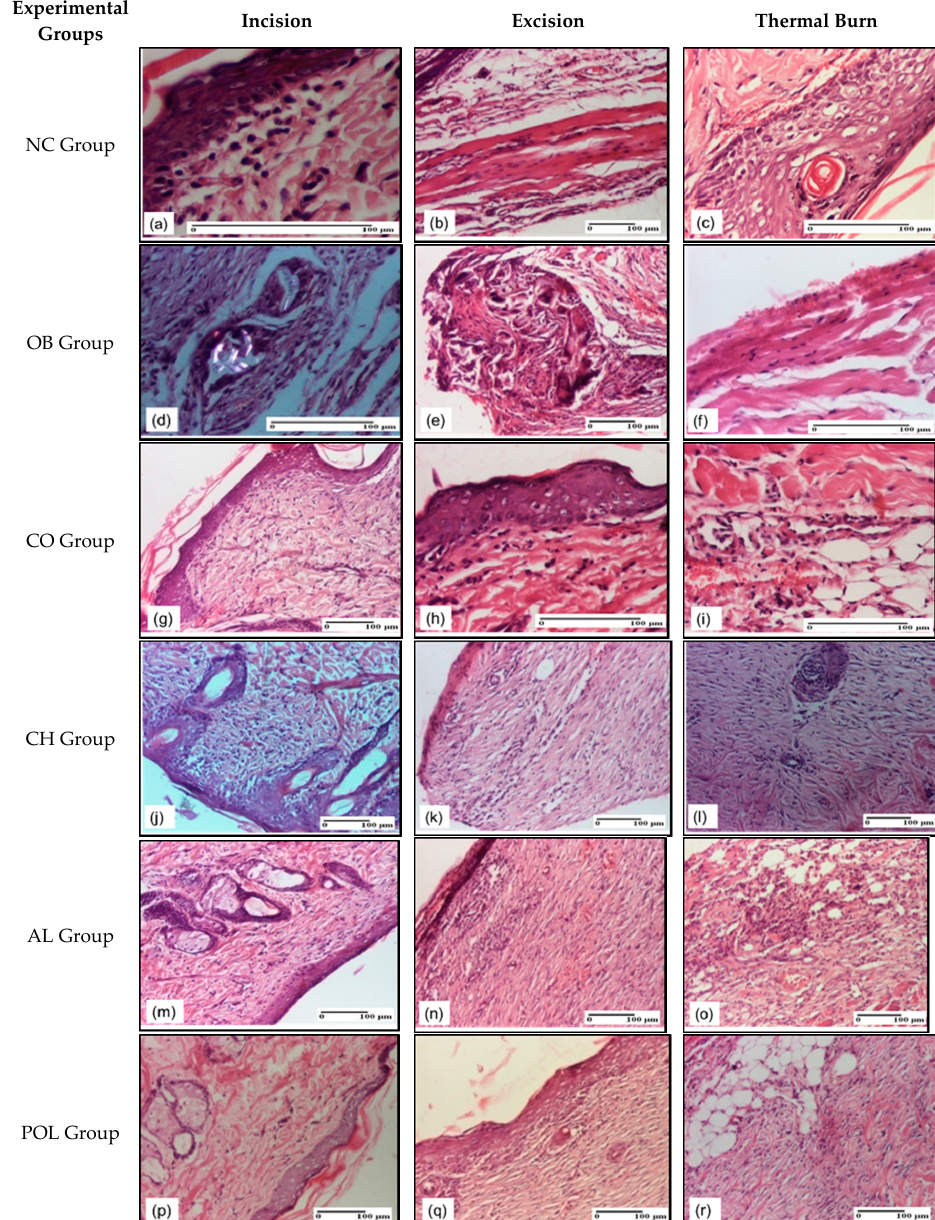
Figure 7. Microscopic histology images on day 9: ( a ) Inflammatory infiltrate in superficial dermis (S1); ( b ) Inflammatory infiltrate in muscular layer (S2); ( c ) Vacuolar degeneration (S1, D0); ( d ) Multinucleated foreign-body giant cells, detail in polarized light microscopy (S2); ( e ) Multinucleated foreign-body giant cells (S2); ( f ) Rare inflammatory infiltrate in muscular layer (S1, D0); ( g ) Dermal collagenization, inflammatory infiltrate in superficial dermis (S1); ( h ) Moderate inflammatory infiltrate in superficial dermis (S1); ( i ) Inflammation in hypodermis (S1, D0); ( j ) Slight dermal collagenization (S2); ( k ) Dermal collagenization (S2); ( l ) Significant dermal collagenization as result of granulation tissue maturation (S1, D0); ( m ) Mature granulation tissue (S1); ( n ) Dermal collagenization (S2); ( o ) Granulation tissue undergoing connective organization associated with important lymphoplasmacytic inflammatory infiltrate (S2, D2); ( p ) Significant dermal collagenization, rare lymphocytes (S1); ( q ) Significant dermal collagenization due to the maturation of granulation tissue (S1); ( r ) Significant dermal collagenization (S2, D0). Inflammatory infiltration scoring: S0 (no inflammatory infiltrate), S1 (mild inflammatory infiltrate), S2 (moderate inflammatory infiltrate), S3 (severe inflammatory infiltrate). The thermal burn depths (D): D0–normal skin, D1–epithelial necrosis within the epidermis, the basement membrane remains intact, D2–necrosis of skin appendages and dermal connective tissue; D3–extensive necrosis within the hypodermic